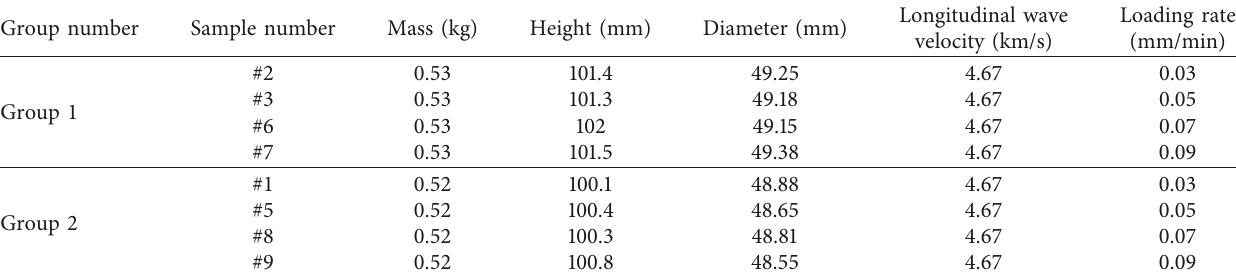
Figure 1: Sandstone samples for the experimental test. Table 1: Grouping of the sandstone